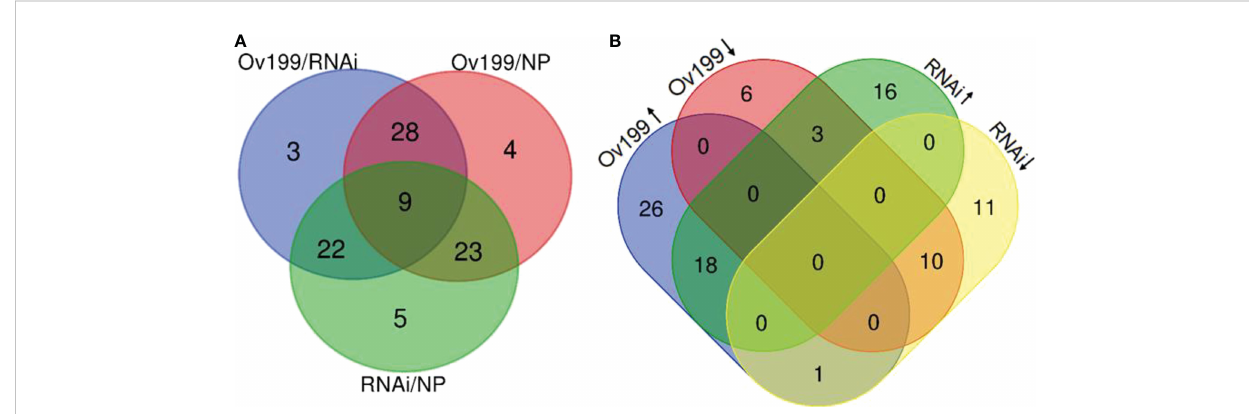
FIGURE 4 Analysis of signi fi cant difference miRNA between NP, Ov199 and RNAi. (A) Venn diagram of unique and shared miRNA with signi fi cant difference expression between Ov199 and NP, RNAi and NP, and Ov199 and RNAi. (B) Venn diagram of unique and shared miRNA with signi fi cant difference expression between upregulated and downregulated miRNA in Ov199 and RNAi compared with